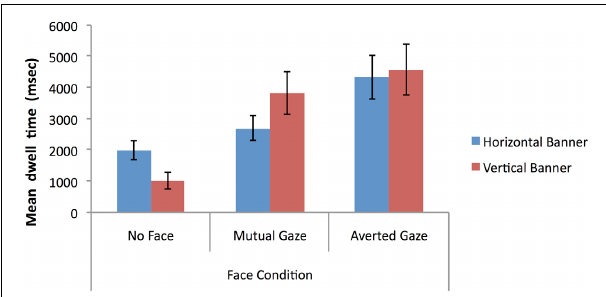
FIGURE 9 | Mean dwell time (milliseconds) on banner advertisements for vertical vs. horizontal banners as a function of face condition (error bars depict the standard error of the